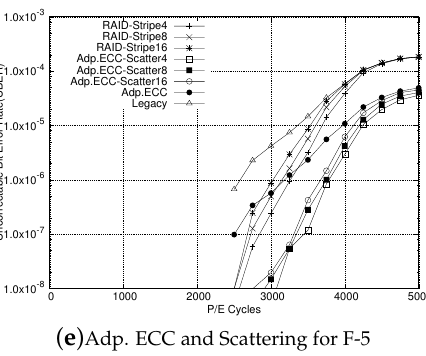
Figure 10. Experimental results for RAID scattering added by adaptive ECC in comparison with the original RAID with various stripe sizes four, eight, and 16. In accordance with P/E cycle, RAID-Stripe4, RAID-Stripe8, RAID-Stripe16, Adp. ECC-Scatter4, Adp. ECC-Scatter8, Ada. ECC-Scatter16 show UBER with stripe sizes four, eight, and 16, respectively. ( a ) Adp. ECC and Scattering for F-1, ( b ) Adp. ECC and Scattering for F-2, ( c ) Adp. ECC and Scattering for F-3, ( d ) Adp. ECC and Scattering for F-4, ( e ) Adp. ECC and Scattering for